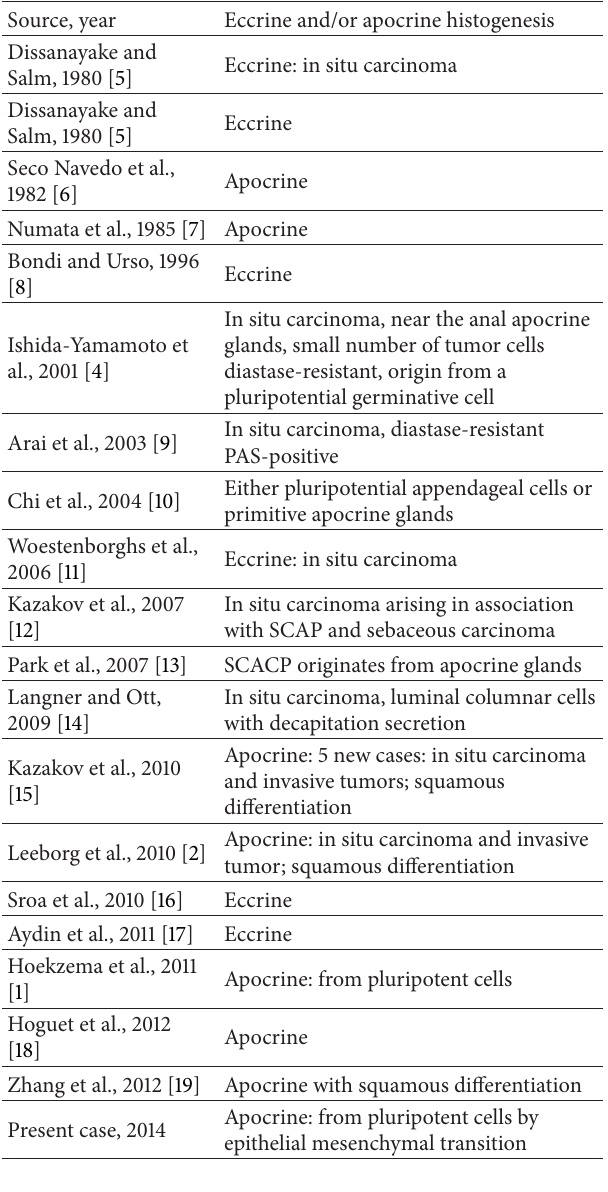
Table 1: Histogenetic theories of syringocystadenocarcinoma papil-